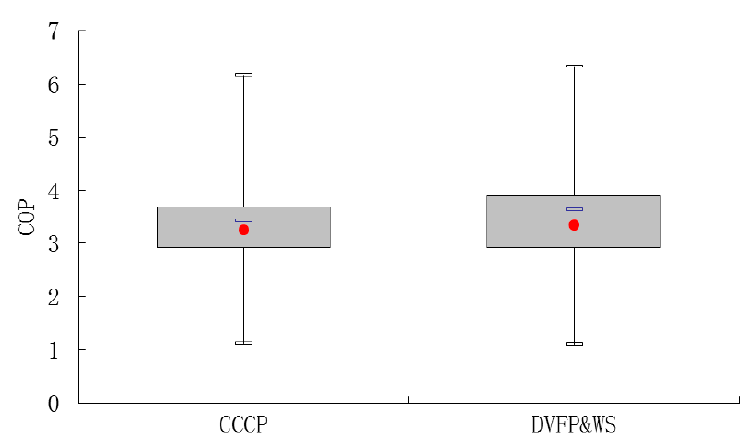
Figure 8. Inlet cooling water temperature for chillers.